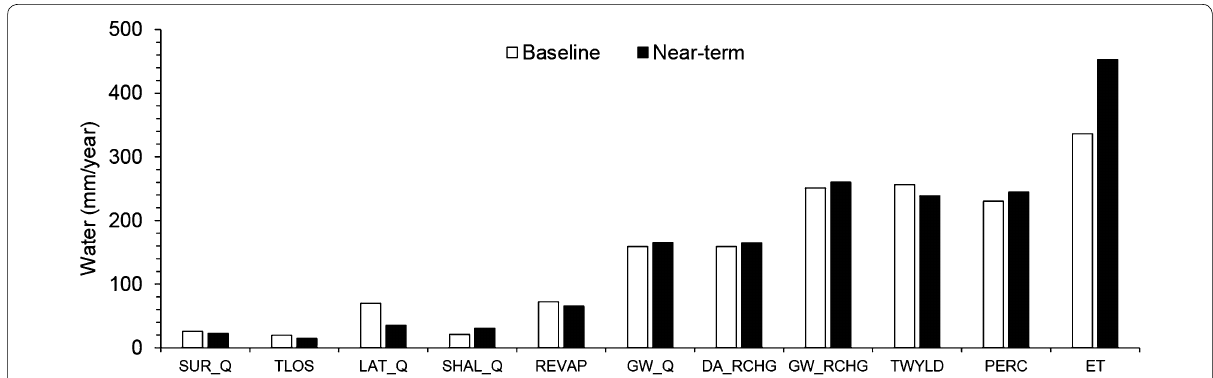
Fig. 21 Near-term water balance simulated under the GCMs ensemble mean climate data compared to the baseline water balance